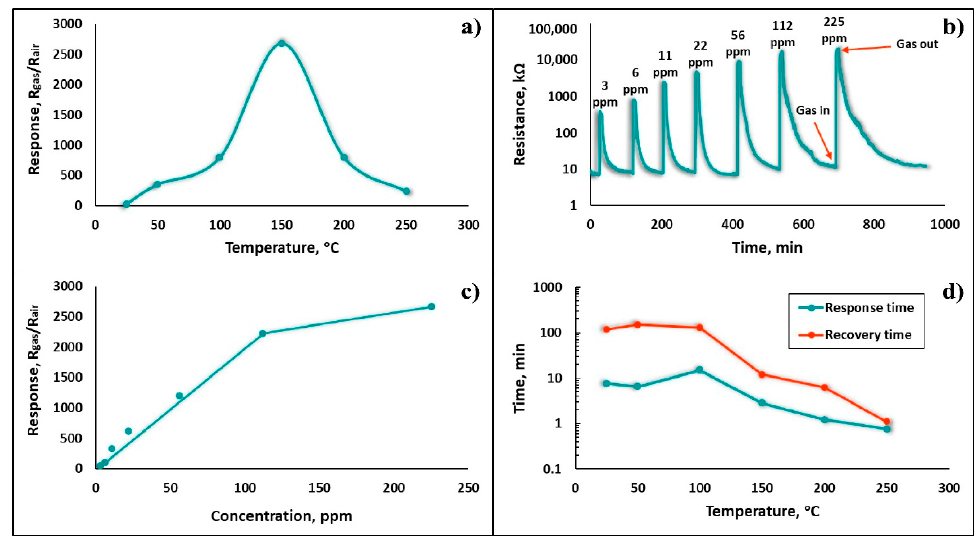
Figure 9. ( a ) Sensor response vs operating temperature at 225 ppm HPV, ( b ) dynamic resistance curves of the sensor to the different concentrations of HPV at 150 °C, ( c ) response vs HPV concentration, ( d ) dependence of the response and recovery times on the operating temperature.